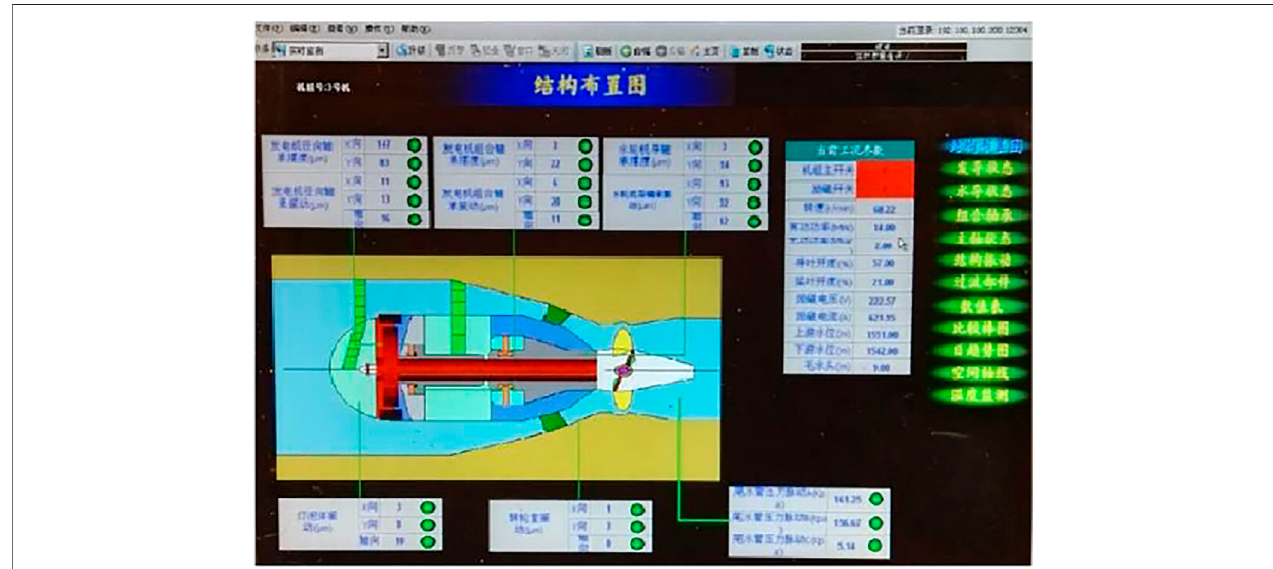
FIGURE 11 | Stability monitoring and analysis system.